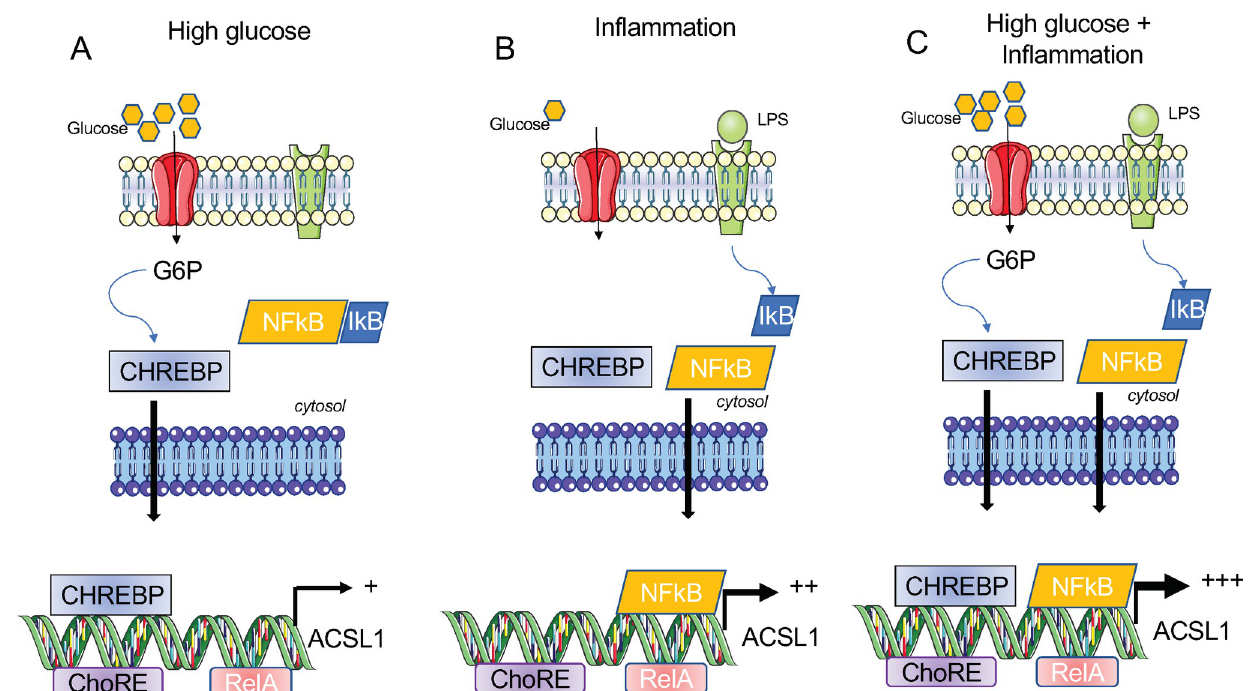
Fig 7. Model for HG and inflammation-induced Acsl1 expression by CHREBP and NF-kappa B in macrophages. A) We propose that in high glucose, CHREBP is depressed, and active nuclear CHREBP promotes the expression of Acsl1 . B) Under inflammatory conditions that activate the NF-kappa B via dismissal of the inhibitory protein I kappa B (IkB) that prevents NF-kappa B nuclear transport, Acsl1 transcription is induced. C) Acsl1 expression can be further increased by high glucose and inflammatory stimuli via CHREBP and NF-kappa B.